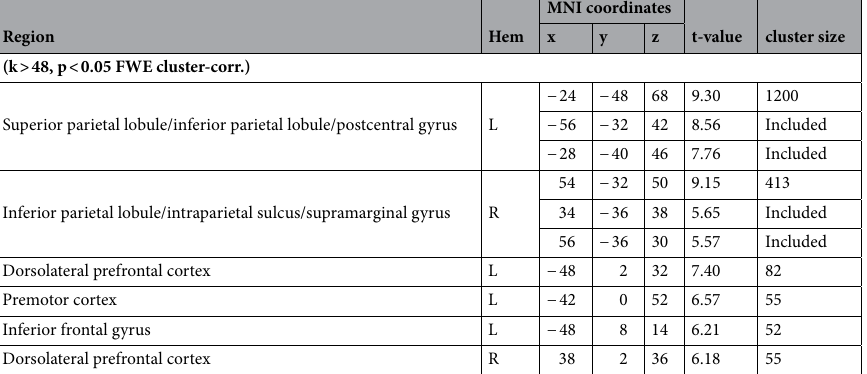
Table 2. Group × working memory load interaction. Anatomical locations and MNI coordinates for the group (HC vs. patients with obsessive-compulsive disorder vs. unaffected first-degree relatives) by working